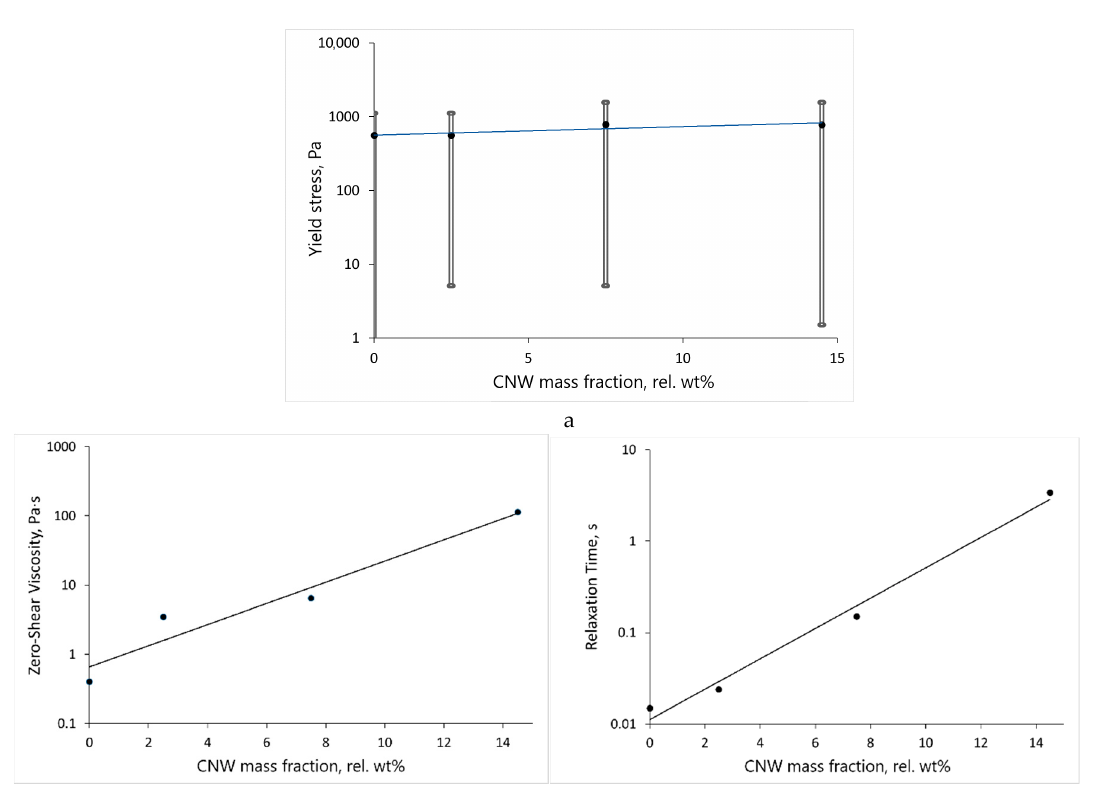
Figure 7. Dependencies of the yield stress ( a ), maximum Newtonian viscosity ( b ), and relaxation time ( c ) of hydrogels on the CNW content. For the yield stress, the minimum and maximum values are shown.